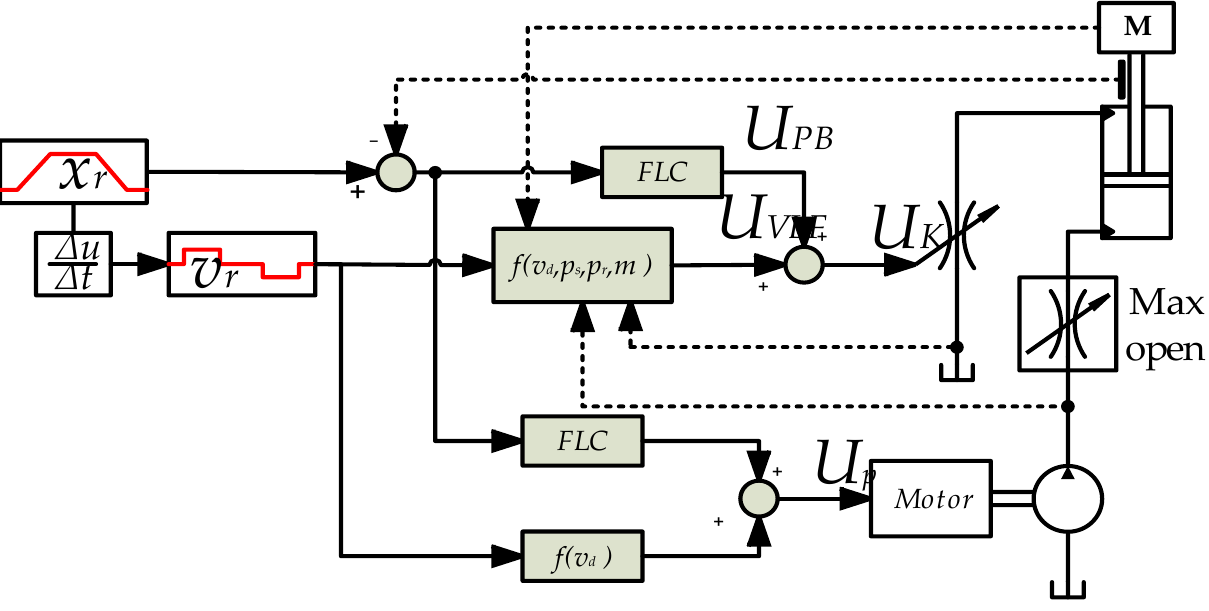
Figure 3. The proposed control method (VLF + FLC) of the NIMV system applies to the boom exca- vator.